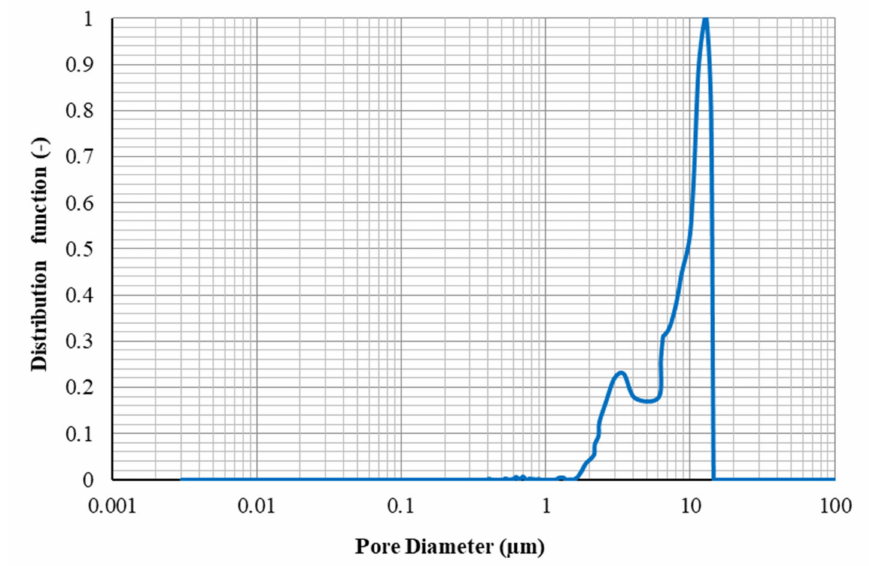
Figure 16. Pore throat size distribution for core A1.